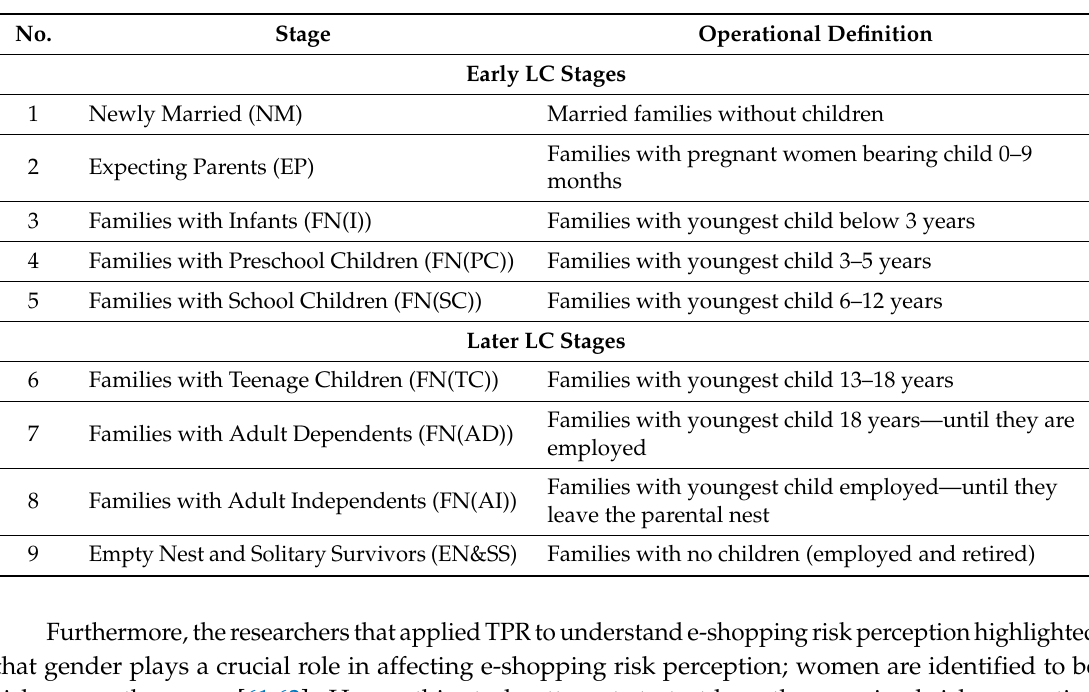
Table 2. Classification of stages of family life cycle.